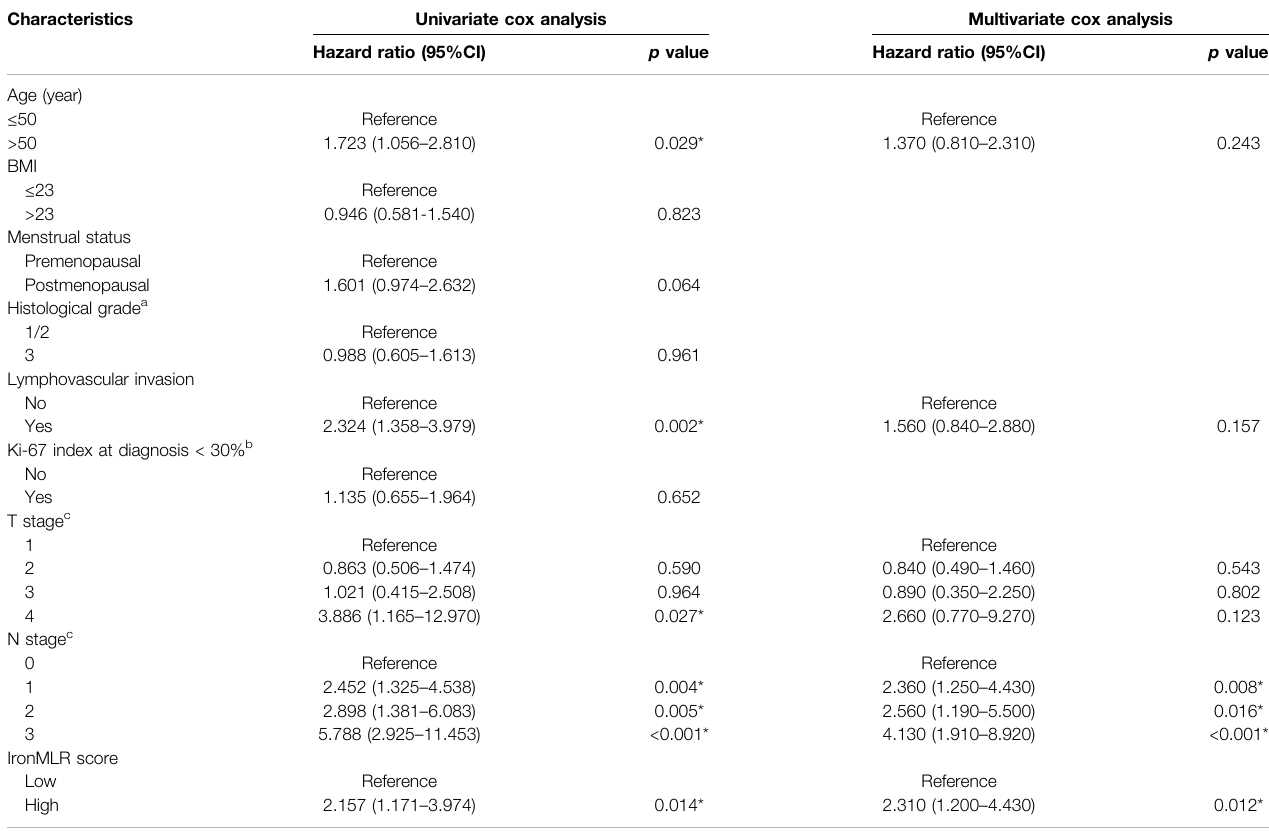
Table 2 | Univariate and multivariate cox regression analysis of disease-free survival.